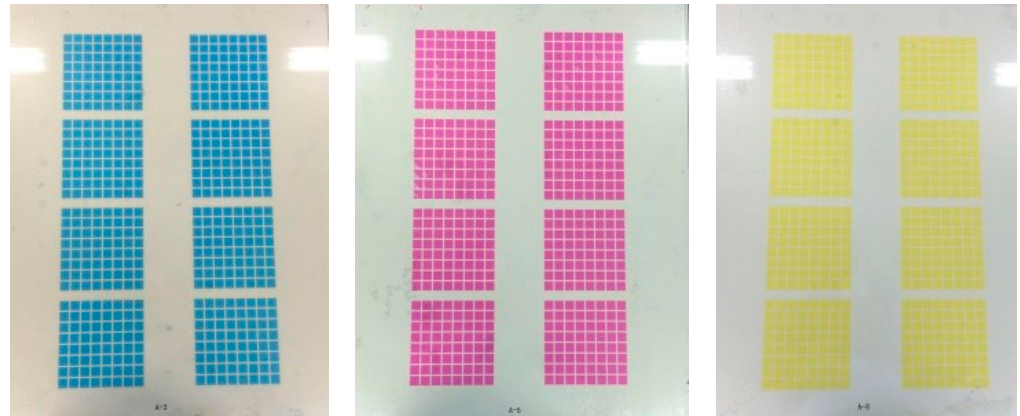
Figure 6. Photos of three color monochromatic segmented electrowetting display G2.5 size glass substrates after the oil/water filling and sealing of assembly step.